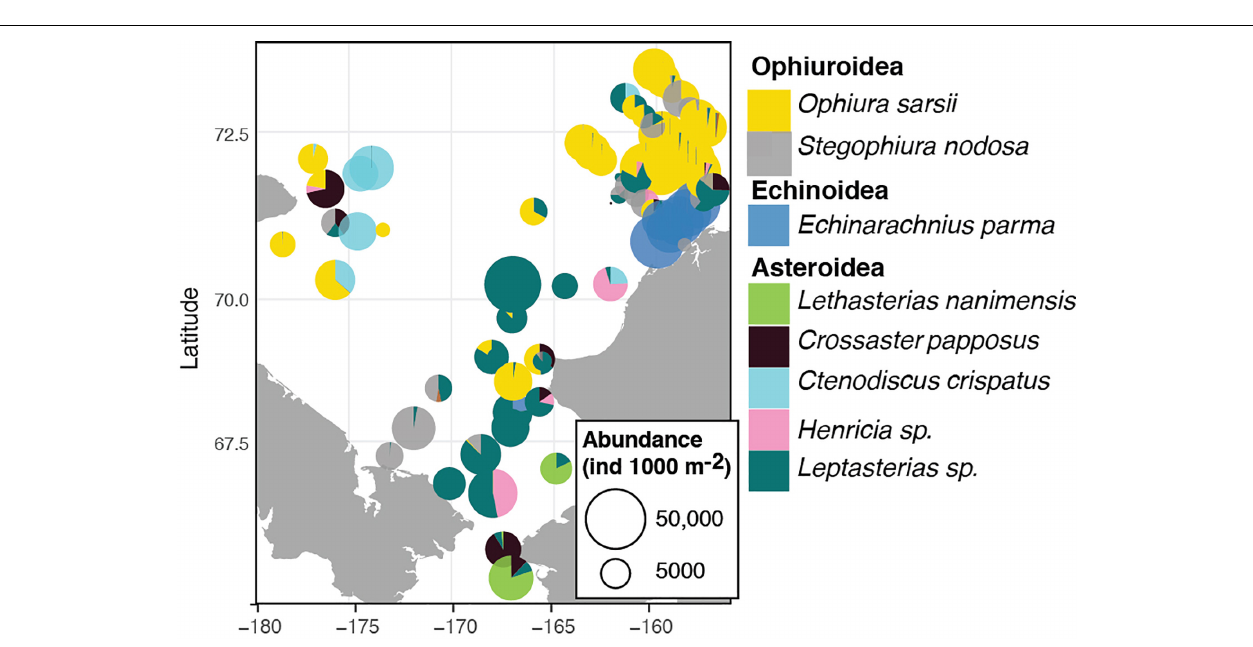
FIGURE 6 | Distribution and relative contribution to abundance of the most common adult echinoderms in the benthos of the Chukchi Sea.